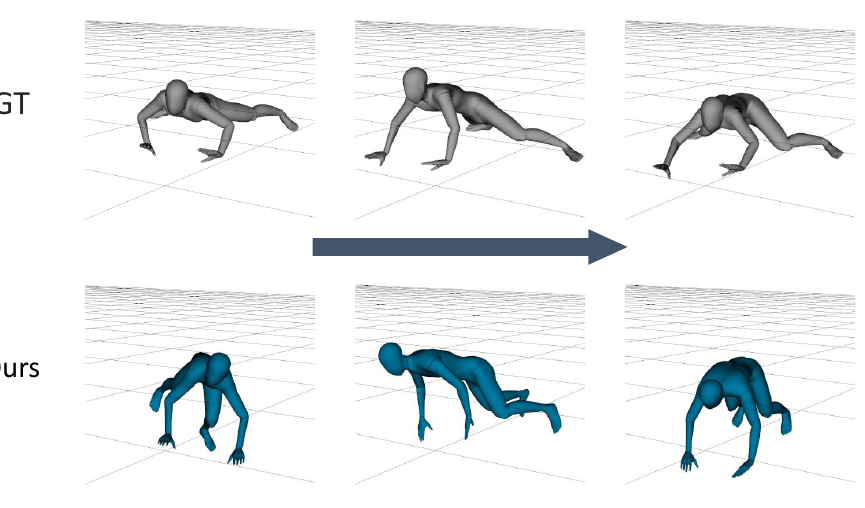
Figure 14. Examples of failure cases for the crawling motion in the TotalCapture dataset: ( top ) the ground-truth motion; ( bottom ) our predicted motion. It was a continuous motion with 15 frame